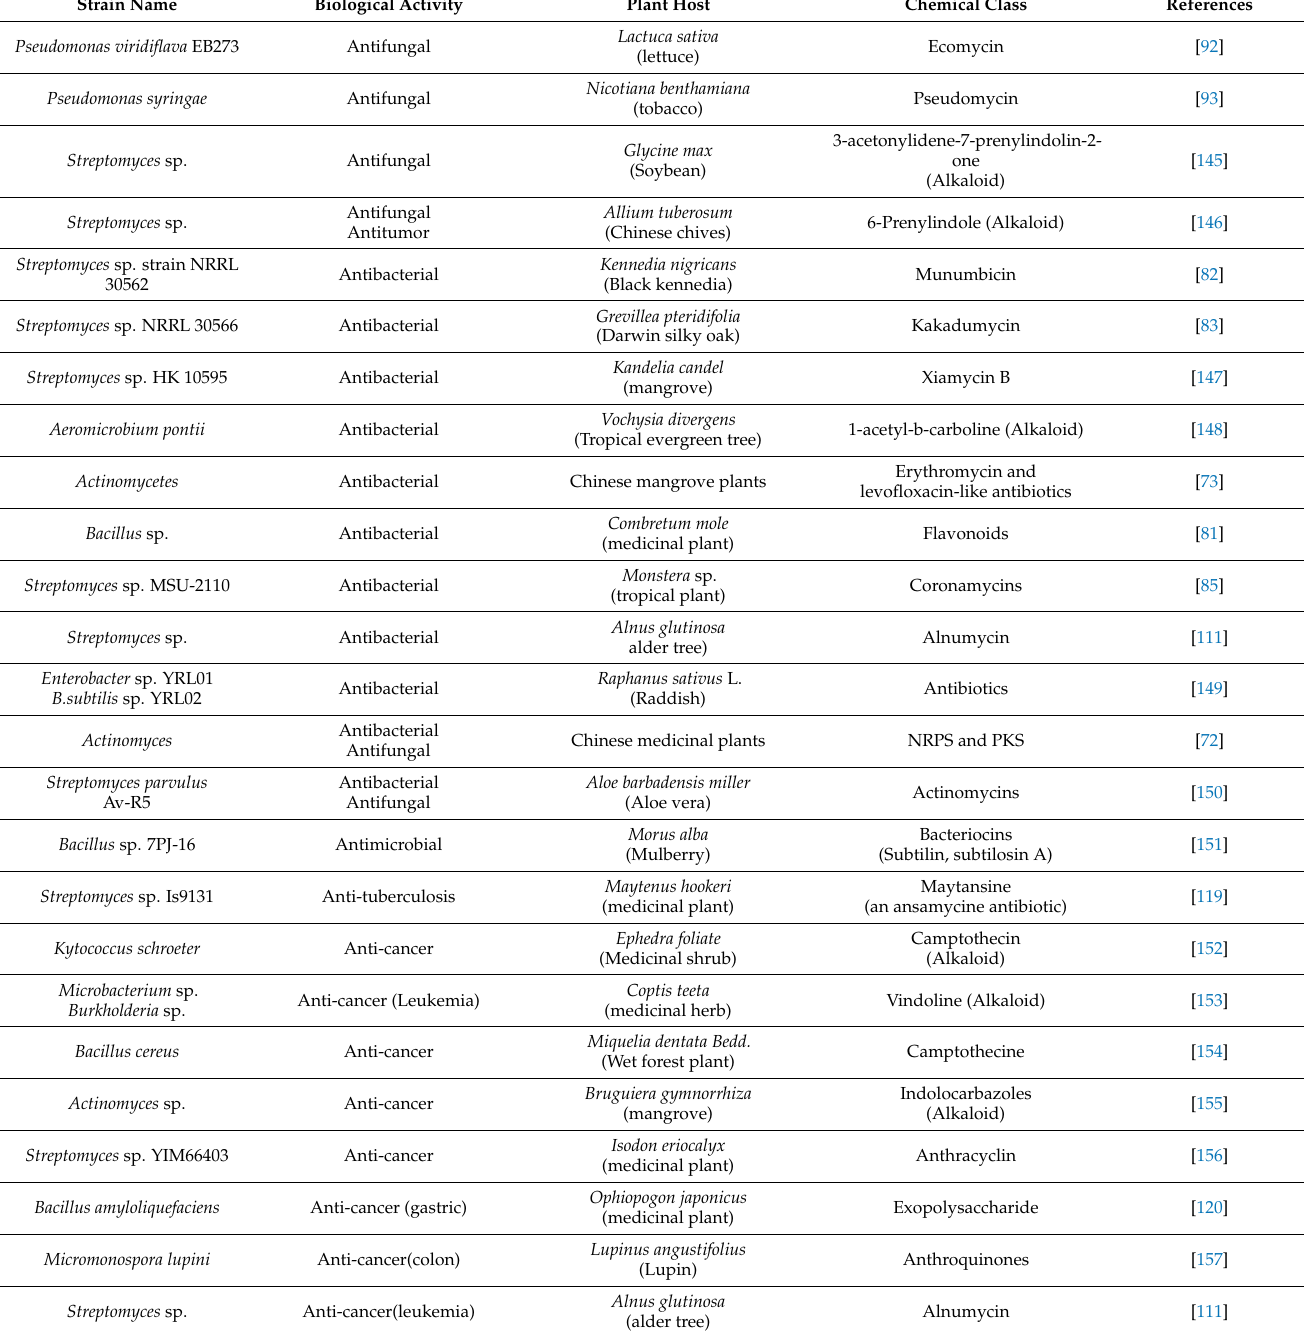
Table 1. Secondary metabolites produced by bacterial